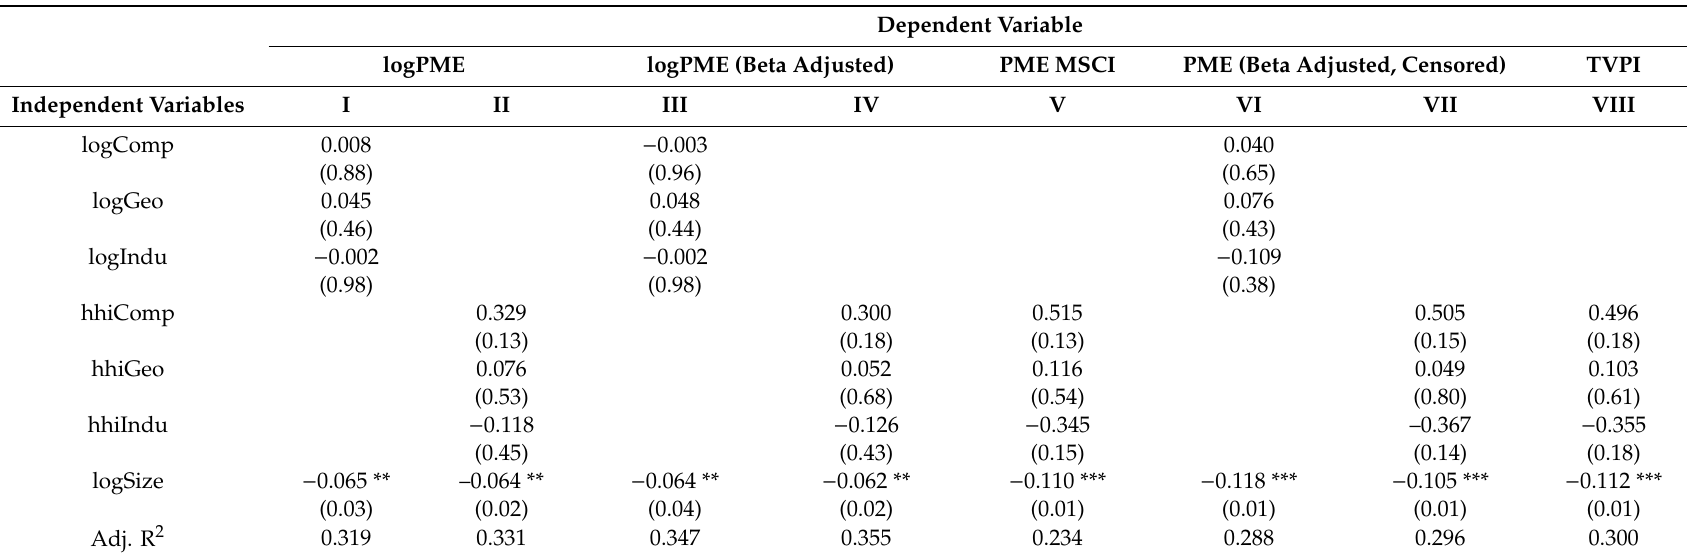
Table A3. Robustness tests (performance